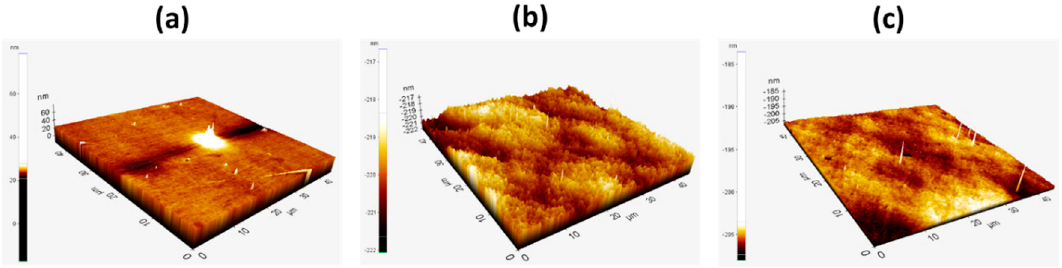
Figure 3. Atomic force microscopy (AFM) image of PVK:OXD-7:TXO-TPA of 8 wt.% in ( a ) chloroform, ( b ) dichlorobenzene, and ( c ) chlorobenzene.